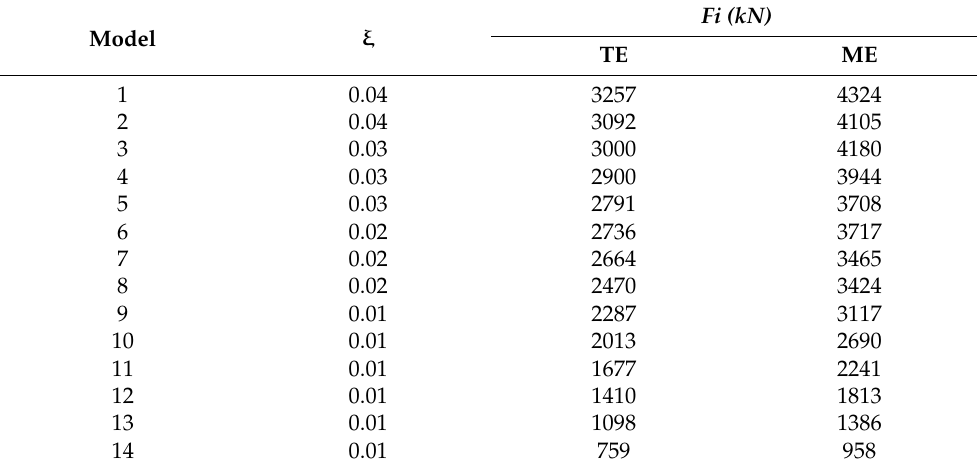
Table 6. Inertial force for Scenario 2.